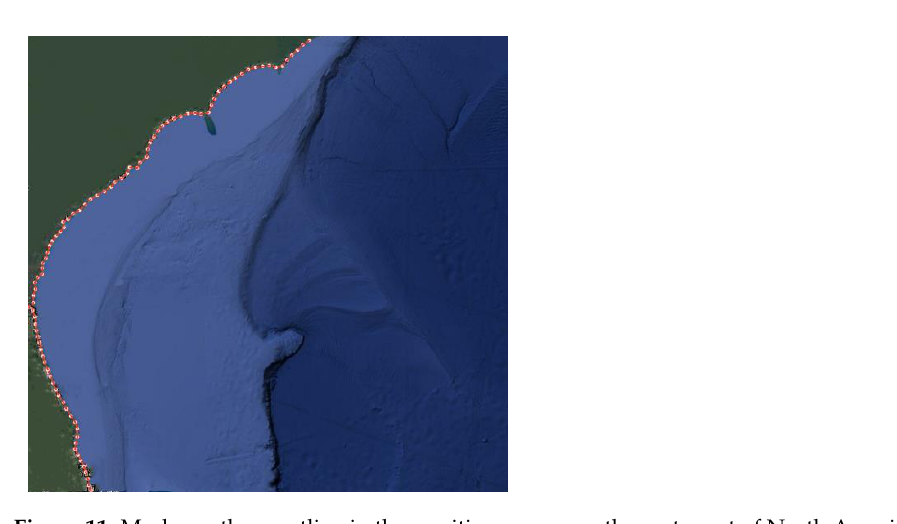
Figure 10. Grid map of maritime traffic density in the maritime area near the east coast of North America.